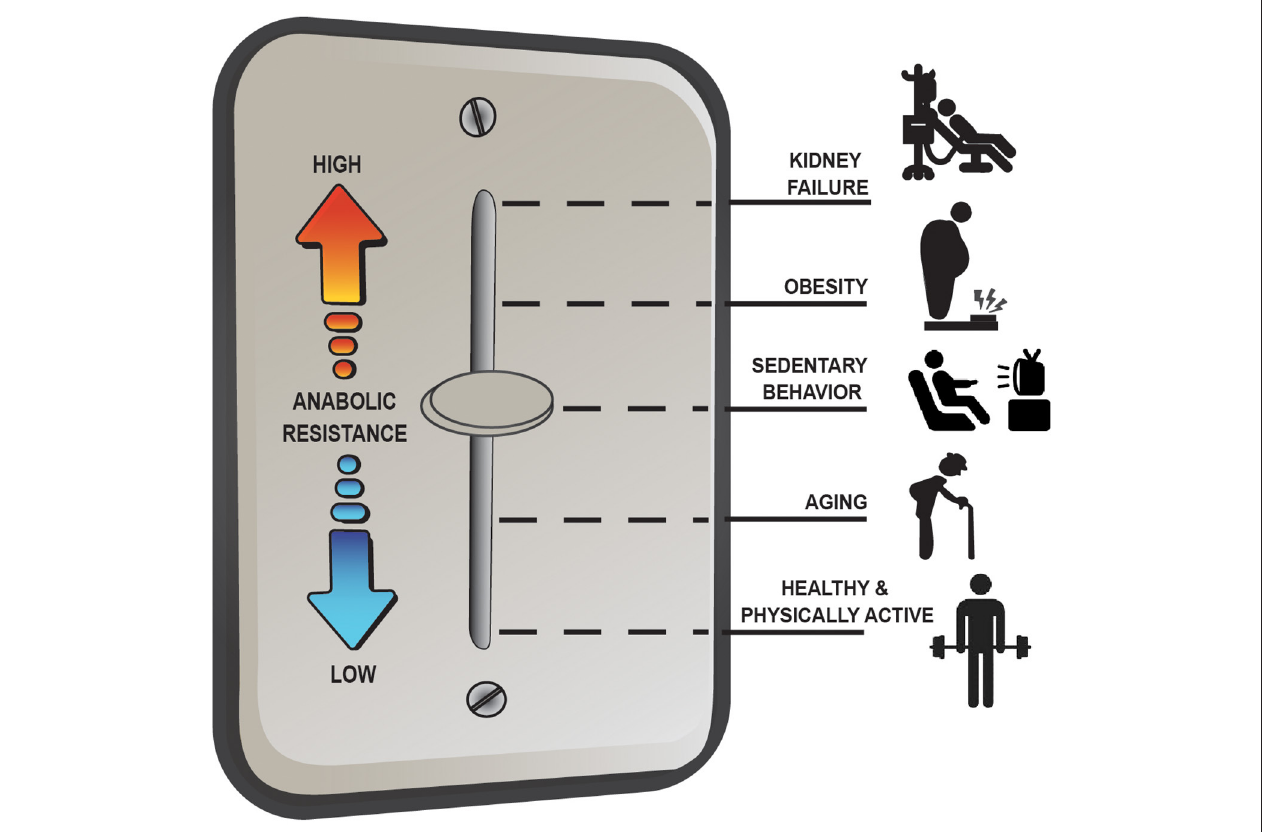
FIGURE 2 | Anabolic resistance of muscle protein synthesis rates (MPS) to dietary amino acids exists as a dimmer switch from low to higher levels. Healthy aging muscle has been shown to be quite responsive to the combined stimuli of feeding and exercise in terms of an MPS response (17), but in absence of prior exercise anabolic resistance is detectable ( 46). Decreasing the physical activity level, which is perhaps exacerbated further when combining increased sedentary behaviors, increases the level of anabolic resistance on MPS ( 67). Similarly, obesity increases the level of anabolic resistance, regardless of age (3, 74), with the highest level of anabolic resistance on MPS existing in highly catabolic conditions such as end-stage renal disease (4).